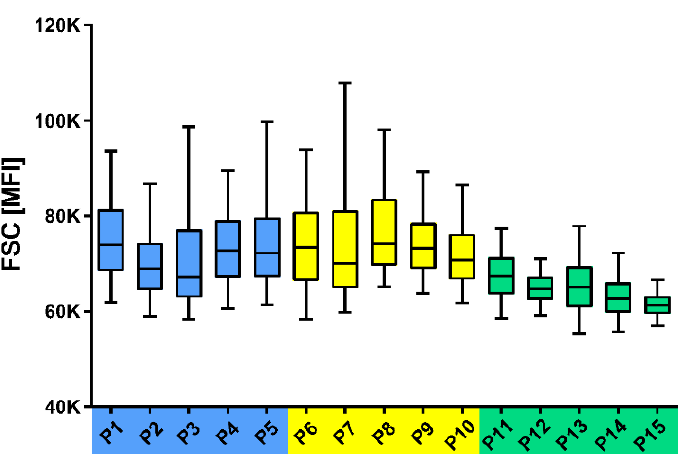
Figure 8. Distribution of CLL cell sizes (expressed as FSC) in the peripheral blood of treatment-naïve CLL patients (P1–P5, blue), patients after immunochemotherapy (P6–P10, yellow) and those receiving ibrutinib (IBR) treatment (P11–P15, green). A representative five patients from each group are shown. The boxplot shows the median, the ends of the boxes indicate the lower (Q1) and upper (Q3) quartiles and the whiskers represent the minimal and maximal values.